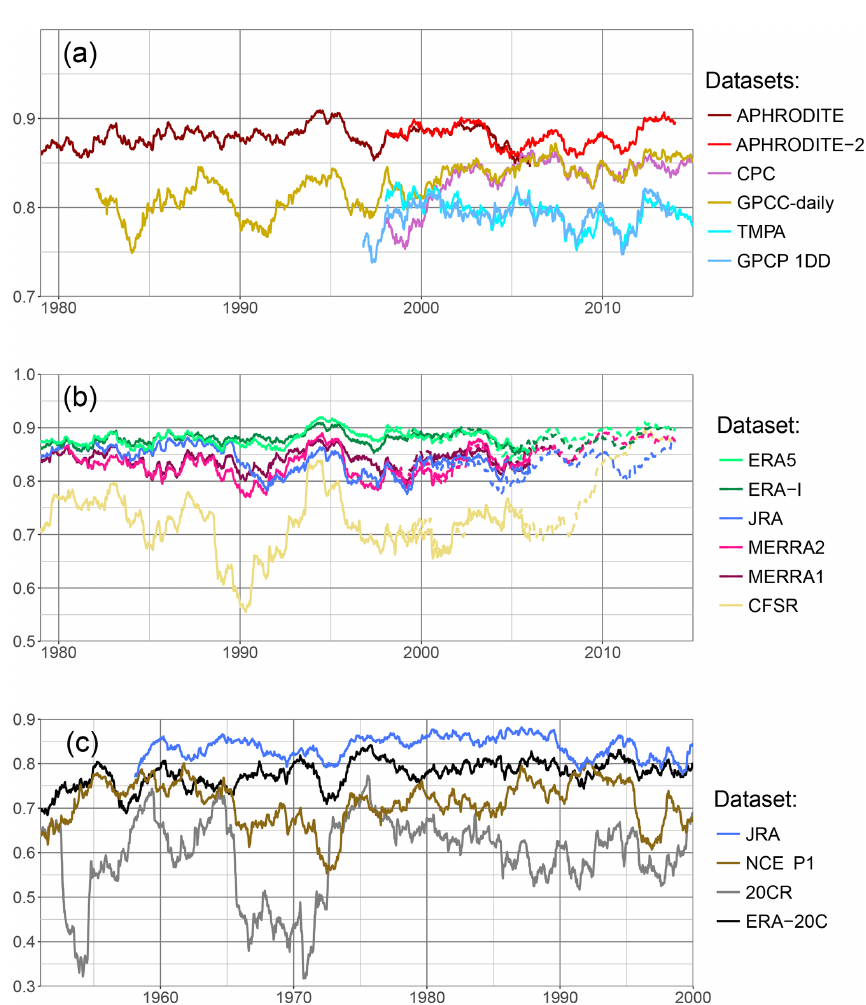
Figure 6. Daily correlation using the Spearman formula, on a running 2-year window, between a reference and different datasets, for the upper Indus. The years on the x axis are the start of the 2-year windows. In (a) observational datasets are tested against ERA-Interim. Panel (b) shows the correlation between a selection of reanalysis and APHRODITE data over the period 1979–2005 (plain line) and APHRODITE-2 over the period 1998–2013 (dotted line). Finally, (c) presents the reanalyses covering the second half of the 20th century, with APHRODITE as